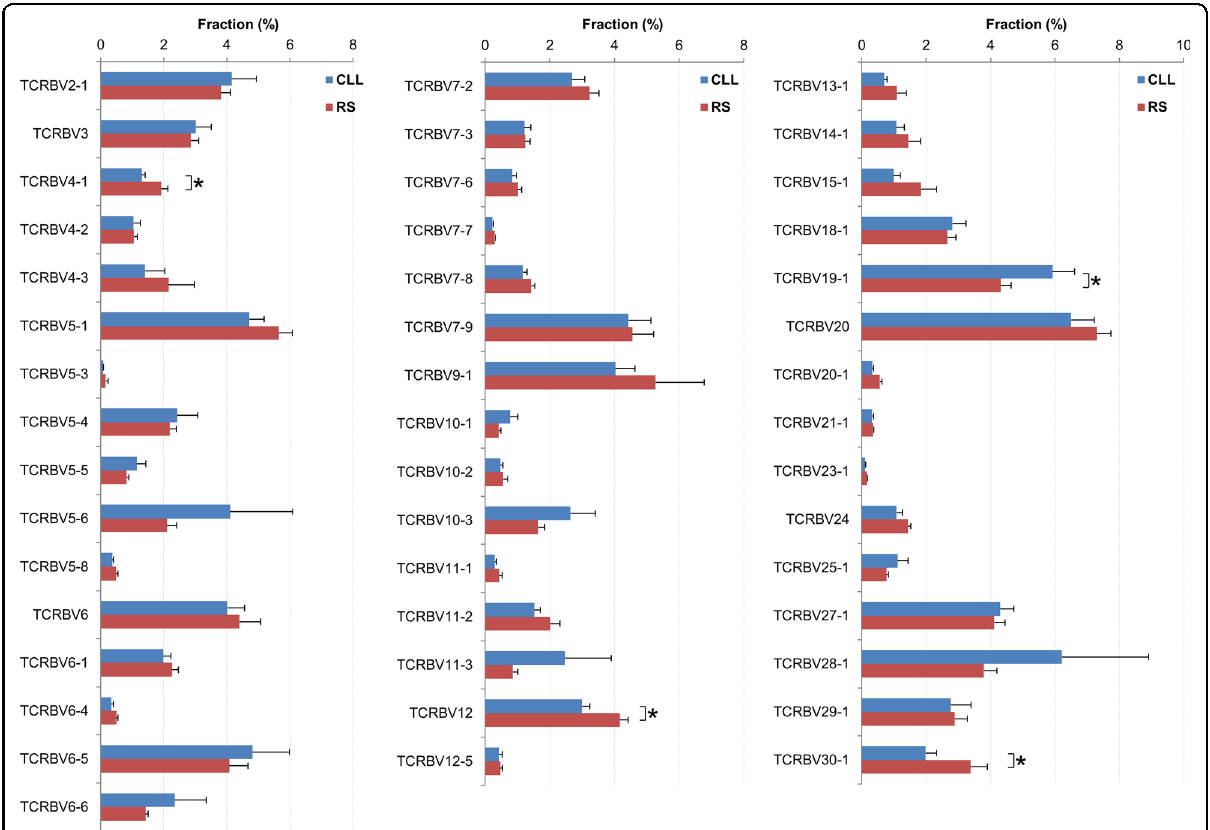
Fig. 3 Distribution of TCR V β gene usage in CLL ( n = 21) vs. RS ( n = 18) cases. Genes with <0.1% fraction in both CLL and RS cases were not illustrated. Asterisk (*) indicates P <